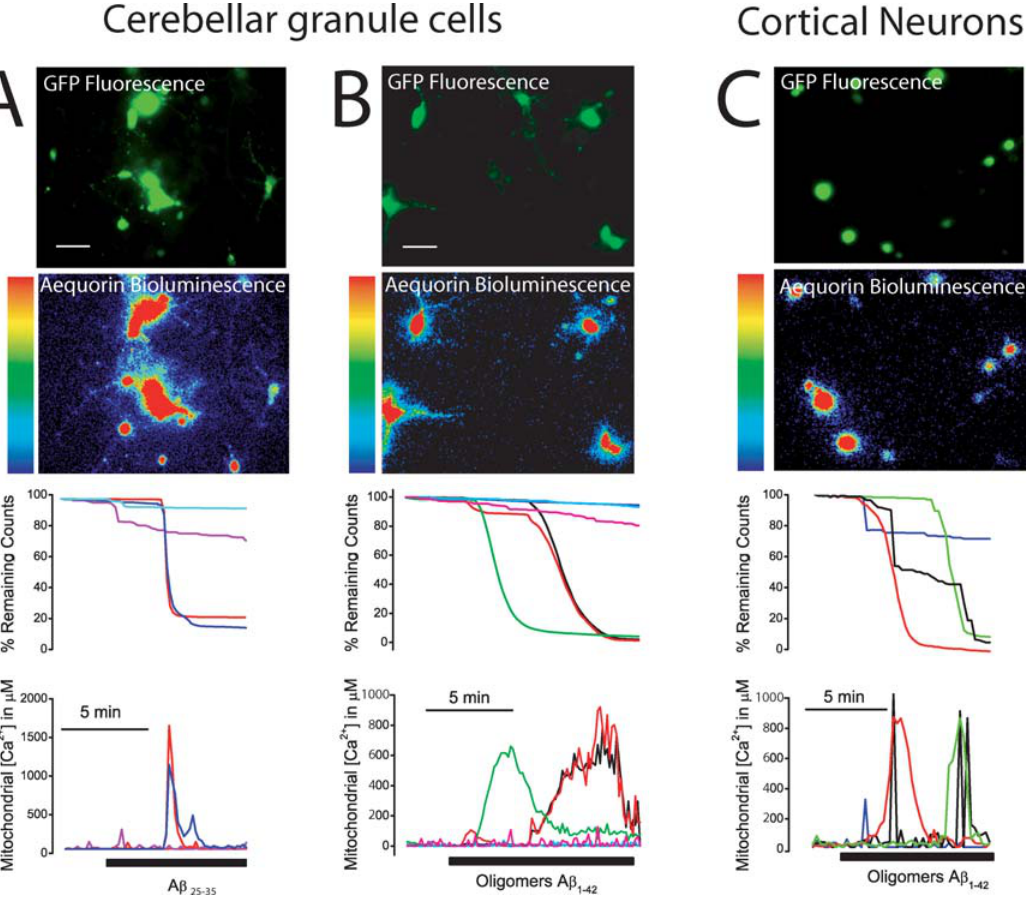
Figure 3. A b 1–42 oligomers induce mitochondrial Ca 2 + overload. Cerebellar granule cells and cortical neurons were transfected with the low- affinity, mitochondria-targeted aequorin fused to GFP, incubated with 1 m M n coelenterazine and subjected to bioluminescence imaging of [Ca 2 + ] mit . Pictures show the fluorescence (top, GFP fluorescence) and accumulated photonic emissions (bottom, Aequorin Bioluminescence) images of representative microscopic fields (scale bar represents 10 m m). Luminescence intensity is coded in pseudocolor (1 to 32 photons per pixel). Traces show the effects of A b 25–35 (20 m M, A) and A b 1–42 oligomers (500 nM, B) on % of remaining counts (top traces) and calibrated [Ca 2 + ] mit (bottom traces) in individual, representative cerebellar granule cells (A,B) and cortical neurons (C). Data are representative of 37, 36 and 68 individual cells studied in 3 independent experiments, respectively.